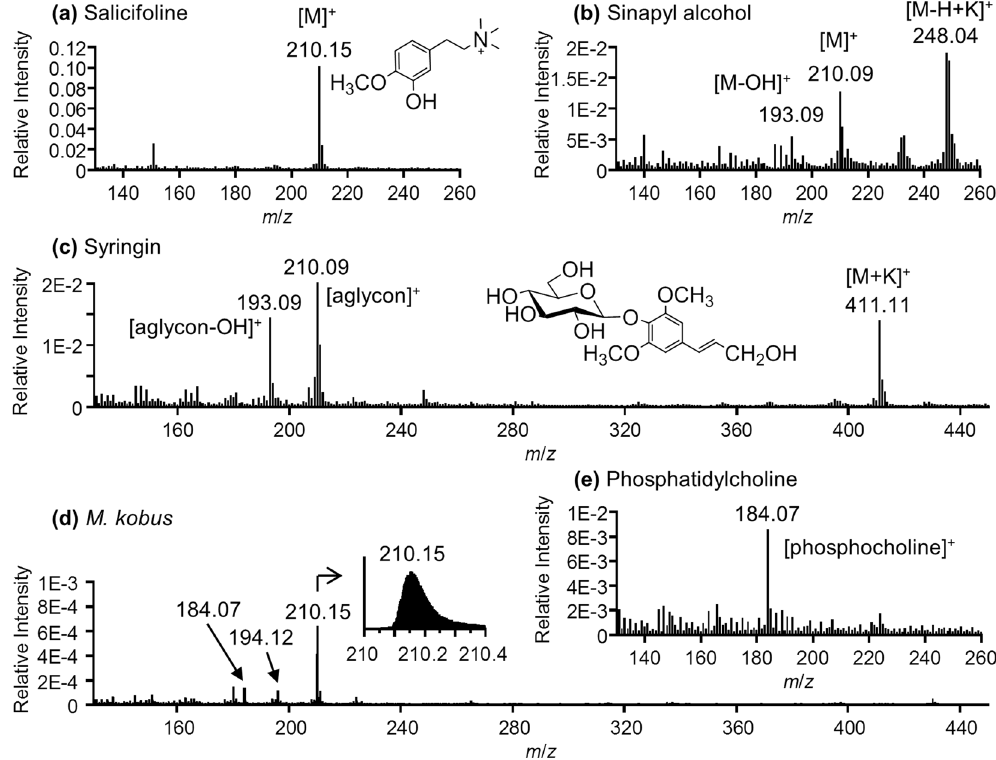
Figure 1. Cryo-TOF-SIMS spectra of ( a ) salicifoline, ( b ) sinapyl alcohol, ( c ) syringin, and ( e ) phosphatidylcholine. A typical cryo-TOF-SIMS spectrum obtained from the transverse surface of the freeze- fixed stem of M. kobus is shown in ( d ). Standard chemicals were dissolved at 100 mM concentration in 100 mM aqueous solution of KCl and frozen for the measurements. All spectra were obtained in bunched mode and are displayed as relative intensity to total ion